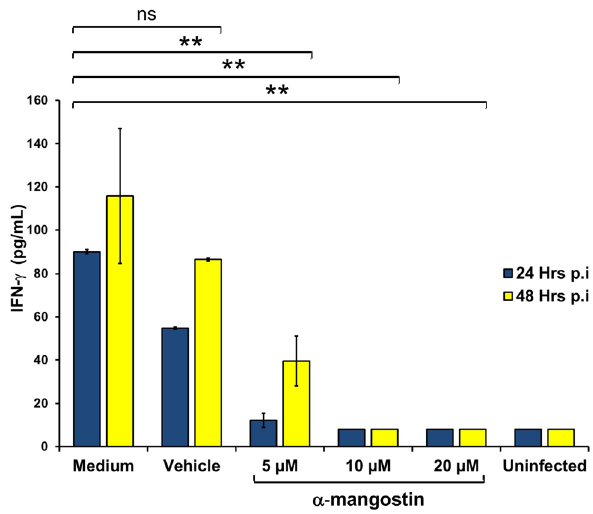
Fig. 3 The effect of α-mangostin treatment to IFN-γ cytokine expres- sion in DENV-infected PBMC at 24- and 48-h post infection. Statisti- cal significance: ns, not significant; **p <